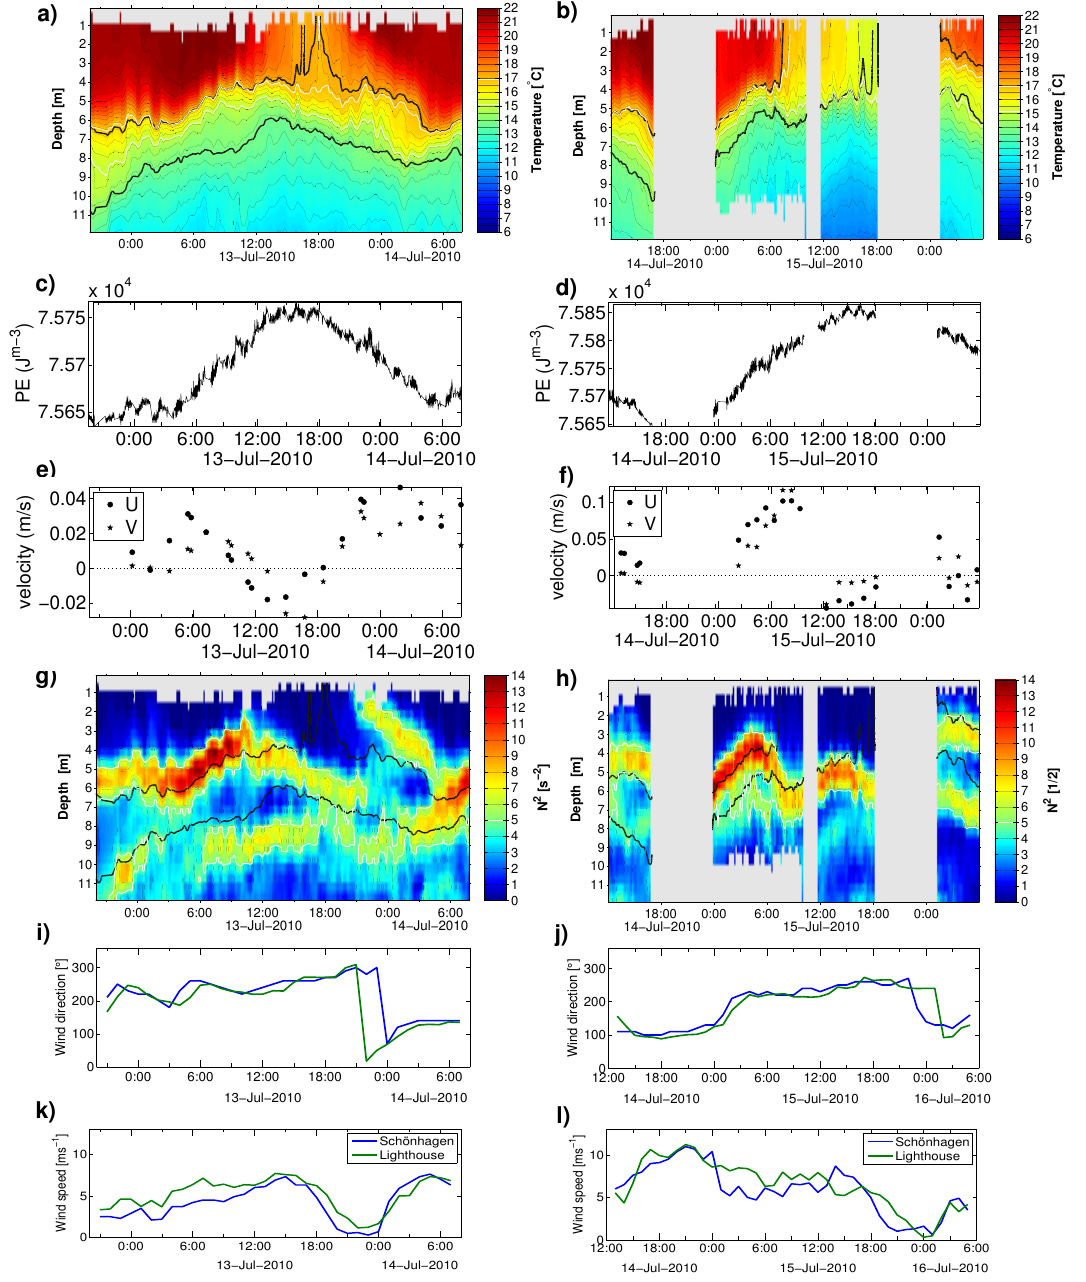
Figure 4. Temporal evolution of selected parameters during the first (left) and second (right) upwelling event. Temperature distribution in the upper 12m (a, b) , potential energy of the upper 10m (c, d) , vertical integrated velocity from glider (e, f) , buoyancy frequency (g, h) , wind direction at both meteorological stations (i, j) and wind speed (k, l)